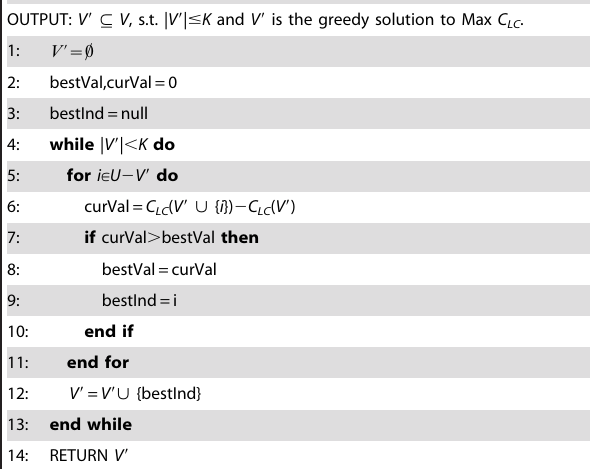
Algorithm: GREEDY- C